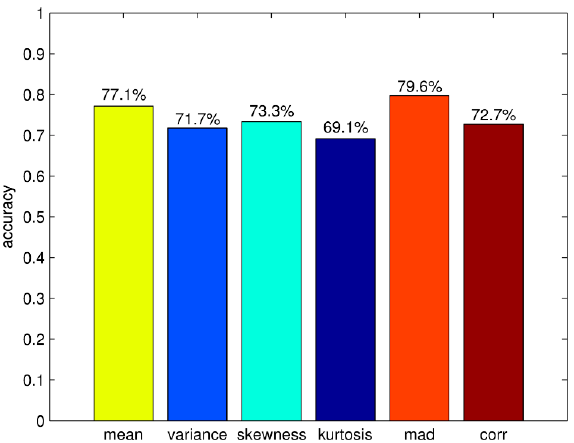
Figure 10. Correct differentiation rates of time domain features.